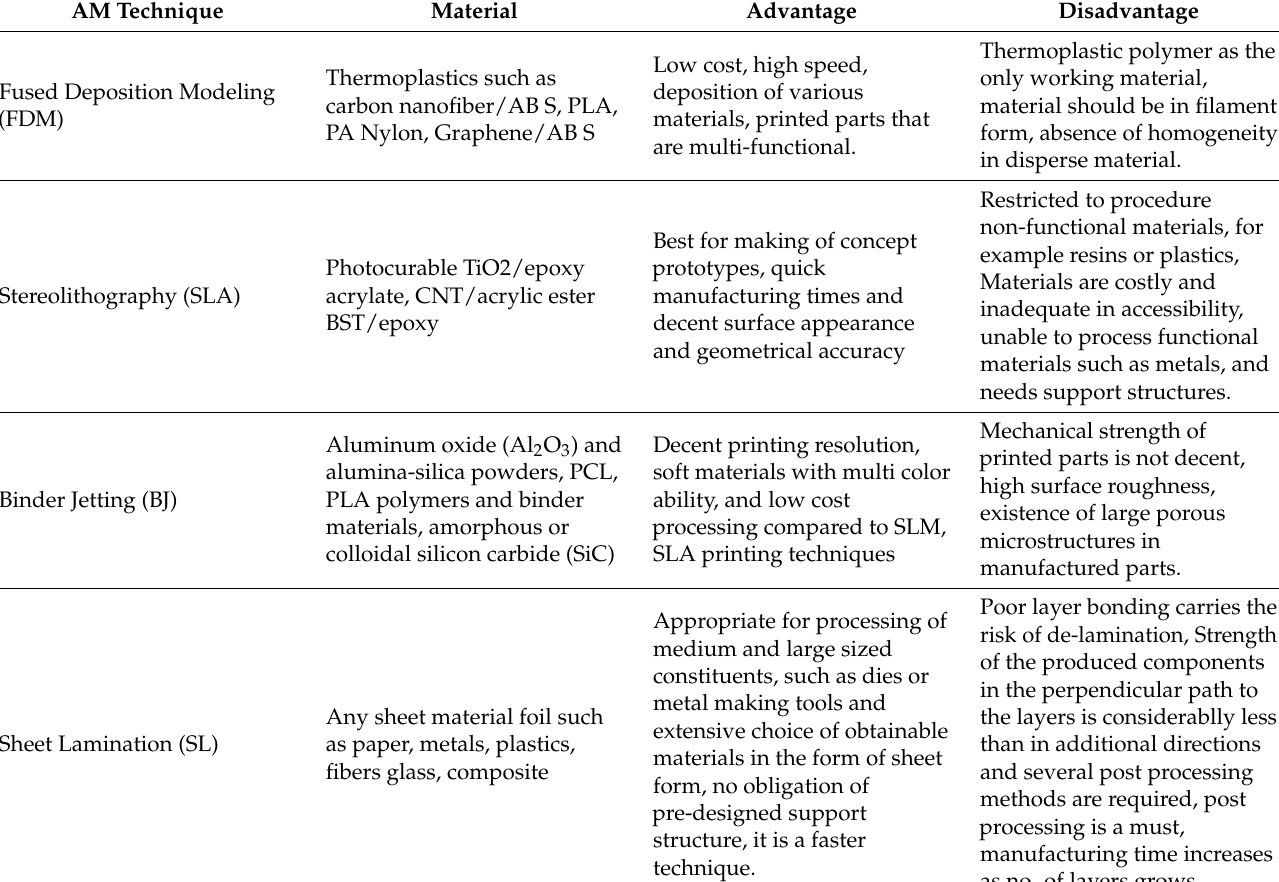
Table 1. Different AM printing methods comparison .